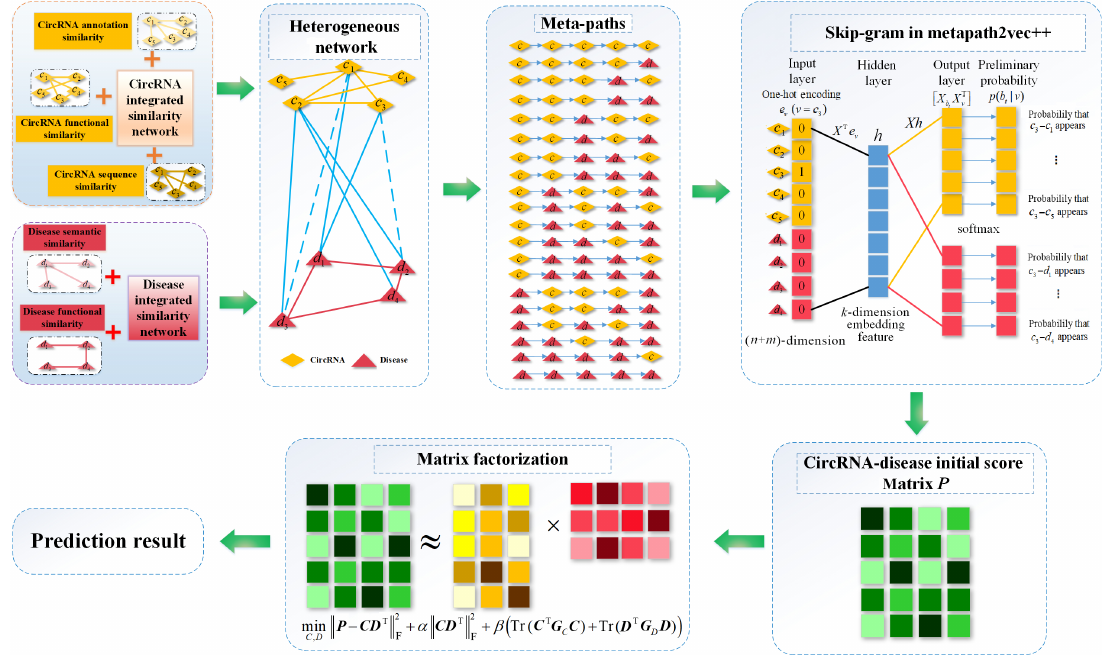
Fig. 1 Overall framework of PCD